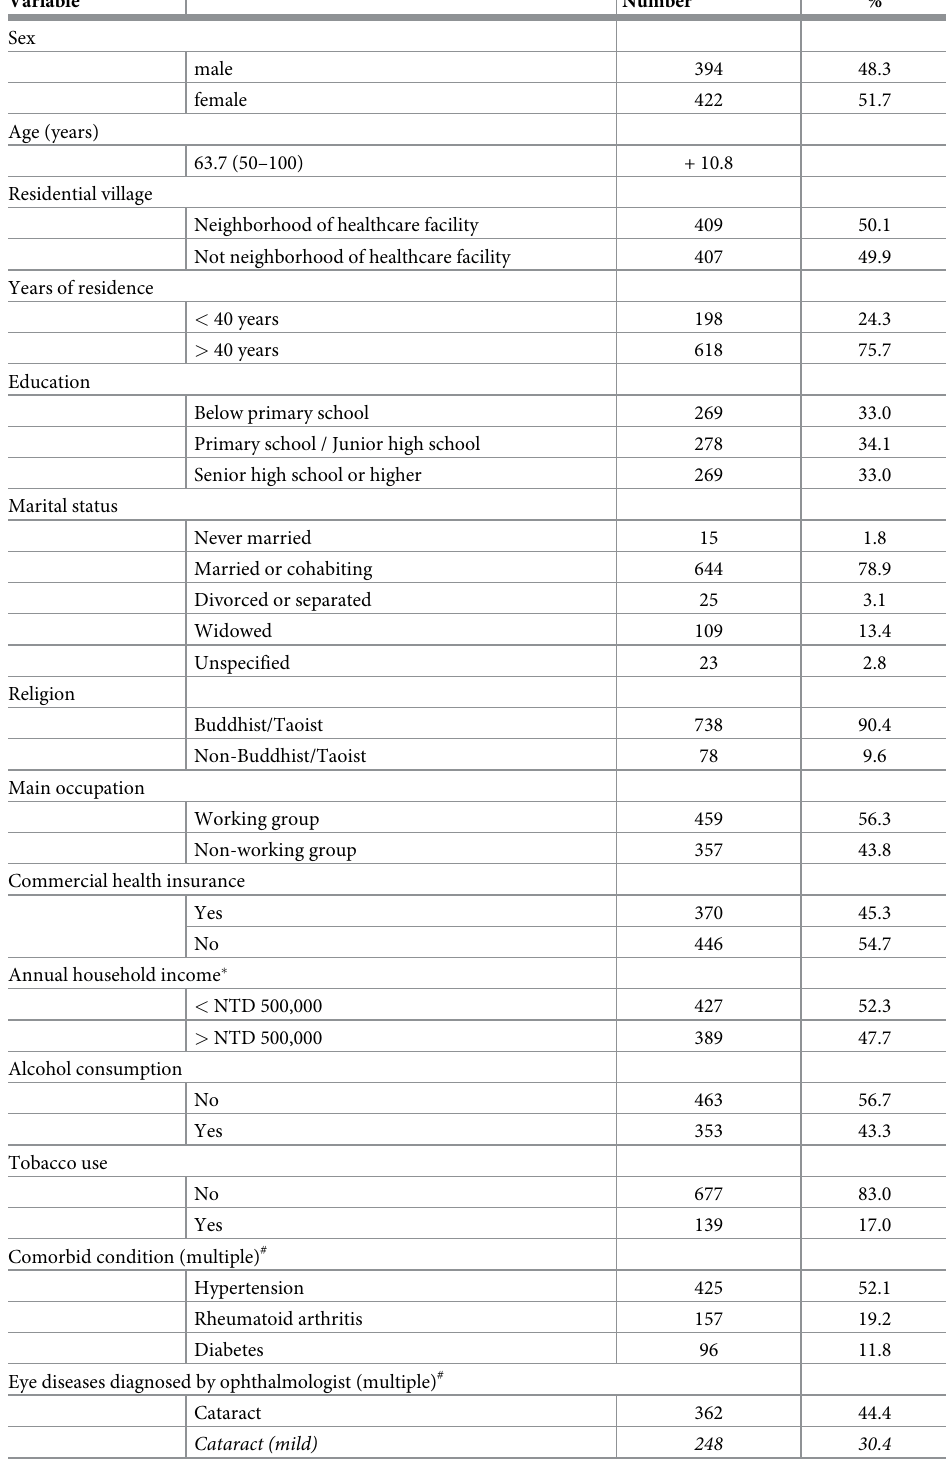
Table 1. Socio-demographic characteristics, health habits, and illness characteristics of study participants (N =